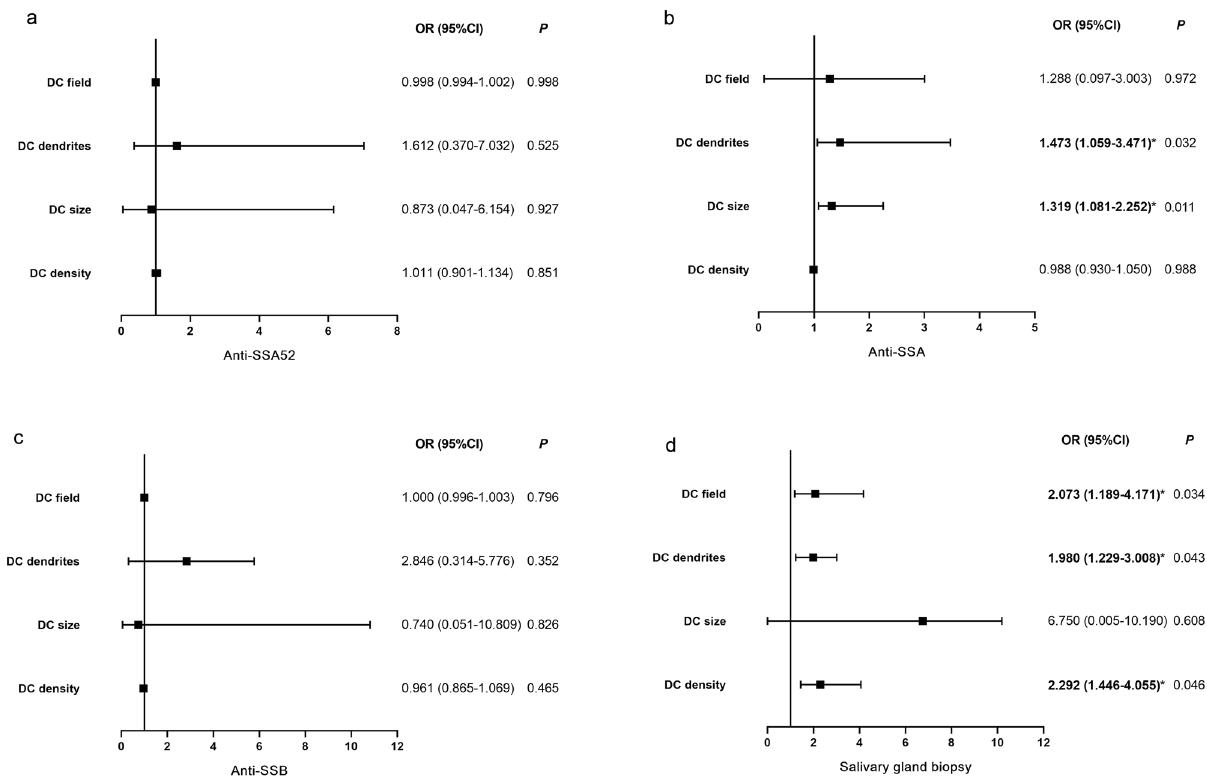
Figure 3. Logistic regression models: associations between DC parameters and anti-SSA52 ( a ), anti-SSA ( b ), anti-SSB ( c ) and salivary gland biopsy ( d ). OR (95% CI) indicates the risk of positive anti-SSA antibody and salivary gland biopsy enhanced when DC density, size, dendrites and field increased. DC dendritic cell, anti-SSA anti-Sjogren’s syndrome A, anti-SSB anti-Sjogren’s syndrome B, OR odds ratio, CI confidence interval; * P < 0.05. DC dendrites (per 1 DC density (per 1 cells/mm 2 ) DC size (per 1 grade)